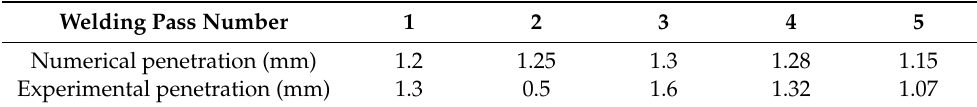
Figure 8. Weld morphology of the predicted vs. measured results (points of A–D are used to mark the position of thermal cycle points): ( a ) simulation results, ( b ) experimental results. Table 4. Numerical and experimental penetrations of the overlaying welding beads.